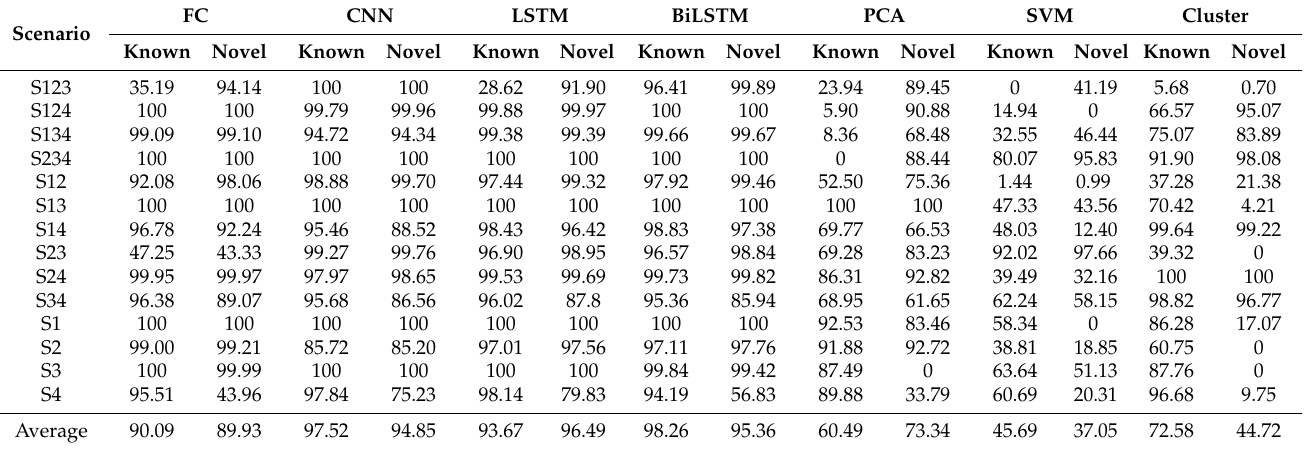
Table 6. Evaluation of the effectiveness in normal conditions with anomalies: F1 Score on the Known and Novel